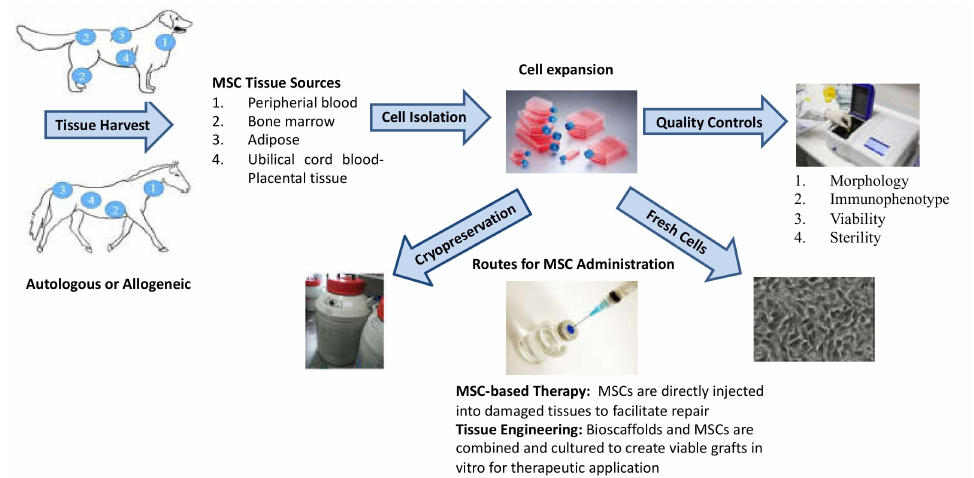
Figure 1. Schematic of equine and canine adult mesenchymal stromal cell (MSC) processing. (Adapted from Duan, W. et al.